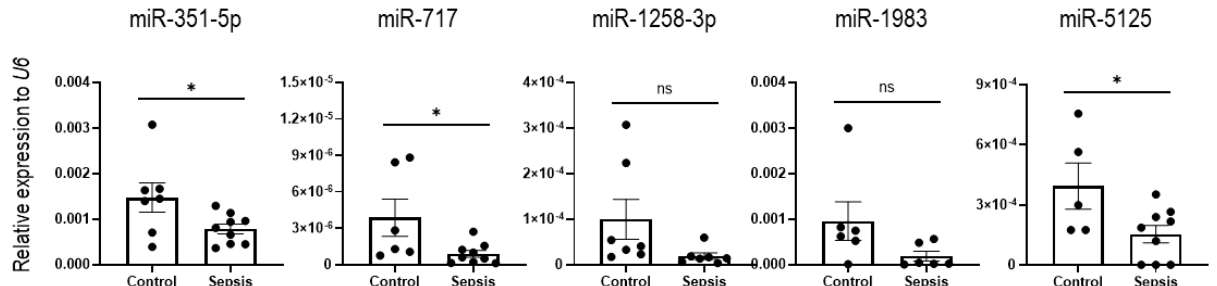
Figure 6. Validation of identified candidate miRNAs downregulated in sepsis IECs. The expression of downregulated miRNAs (miR-351-5p, miR-717, miR-1258-3p, miR-1983, and miR-5125) was tested by using RT-qPCR analysis. U6 was used as an endogenous control to normalize miRNA expression levels. Data are shown as scatter plots and bars overlaid with the mean ± standard error of the mean (SEM). Dot on the plot represents the value of each mouse. Control and sepsis indicate the IECs isolated from sham and sepsis cohorts, respectively. * p < 0.05 and ns, not significant.